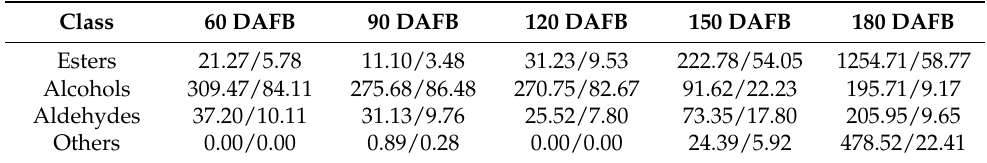
Table 6. Total content ( µ g/kg) and percentage (%) of each type of volatiles in ‘Orin’ apple pulps